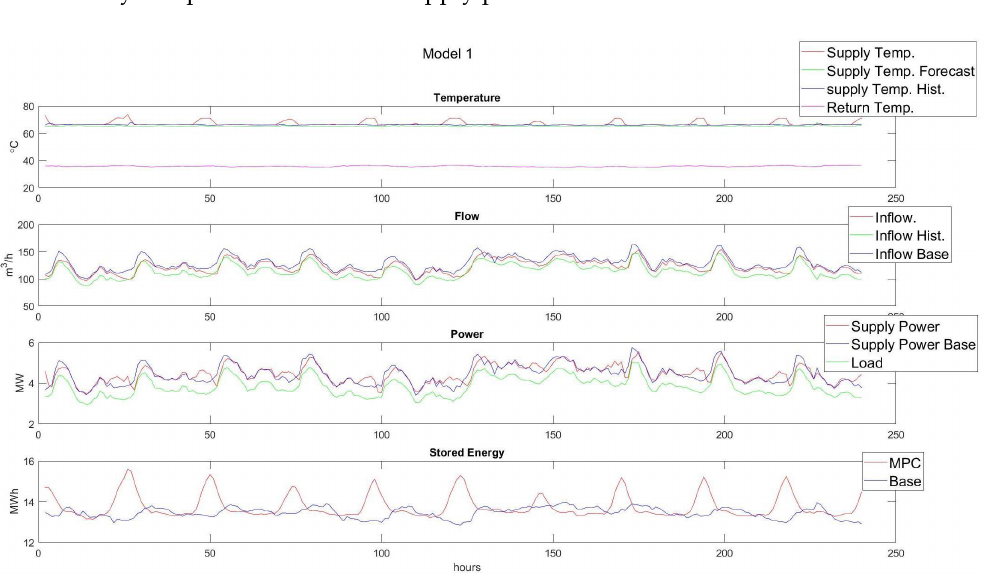
Figure 6. Performance results of model 1, showing peak shaving through heat storing. MPC results (red), base simulation (blue), and historic results (green).